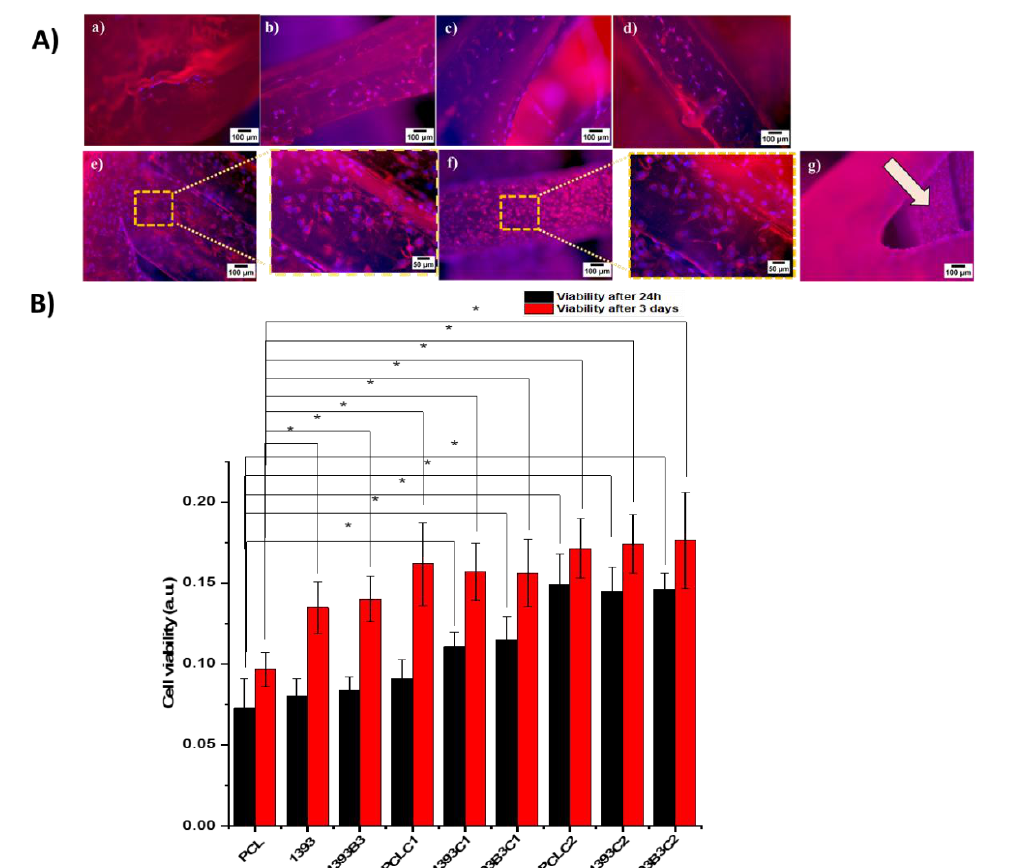
Figure 9. Results of direct cell analysis of coated and uncoated scaffolds with osteoblast-like cell line MG-63. ( A ) Fluorescence images of uncoated PCL ( a ), PCL/13-93 ( b ), PCL/13-93B3 ( c ), and coated scaffolds PCL ( d ), PCL/13-93 ( e ), PCL/13-93B3 ( f ), and cell attachment on the inner struts ( g ). ( B ) Cell viability of all scaffolds after 24 h and 3 days, with p < 0.05 (*) considered statistically significant.